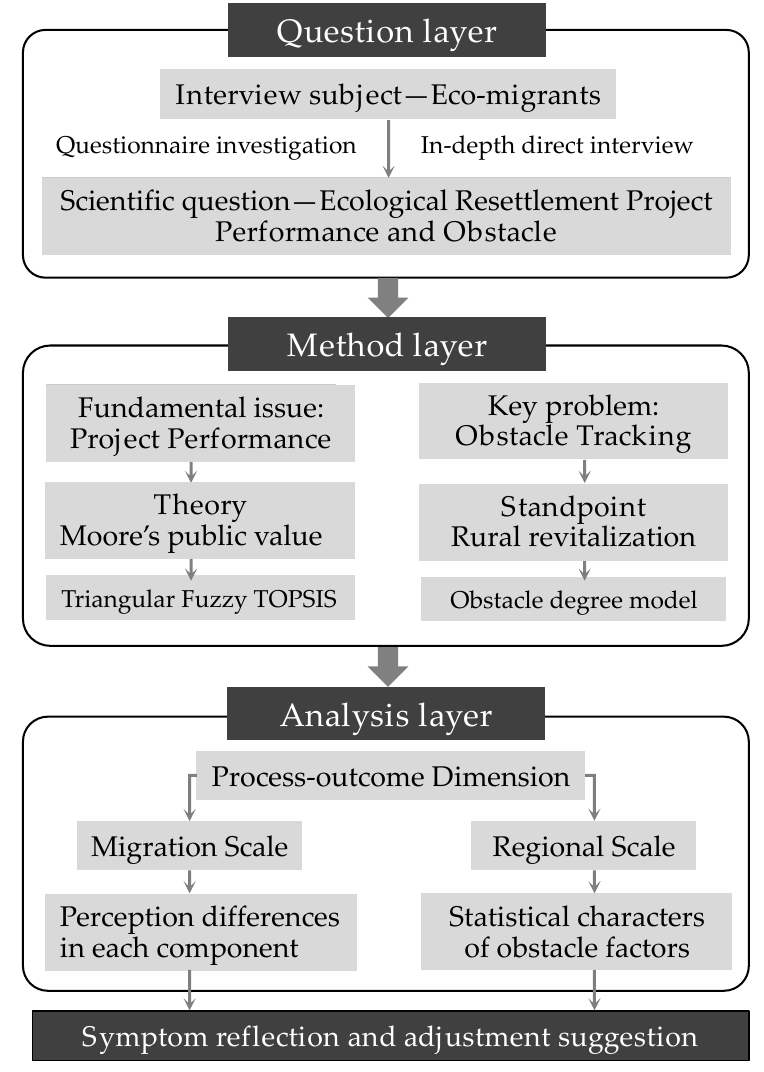
Figure 1. The analysis flow chart.